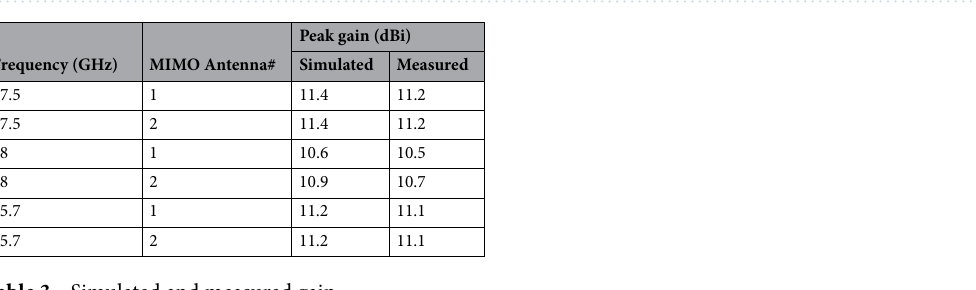
Table 3. Simulated and measured